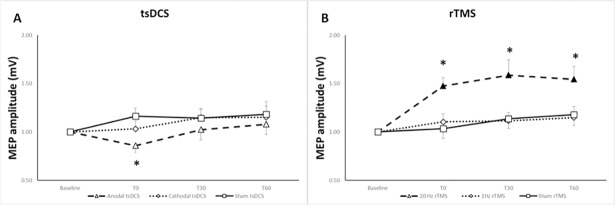
Induced effects of non-invasive stimulation combined with treadmill in the corticospinal excitability.A: MEP amplitude after trans-spinal direct current stimulation associated with treadmill. B: MEP amplitude after repetitive transcranial magnetic stimulation associated with treadmill. Shown are the mean ± SE of baseline-standardized MEP amplitude before (baseline), immediately after (T0), 30 minutes (T30) and 60 minutes after experimental conditions (T60). Filled symbols indicate significant (p< 0.05) changes compared to baseline. *p < 0.05 compared to sham condition.